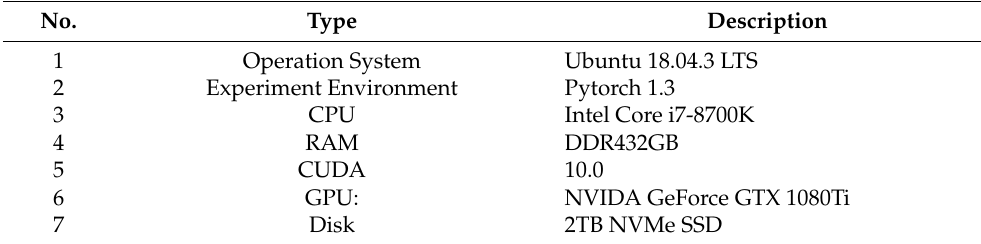
Table 4. Hardware and software